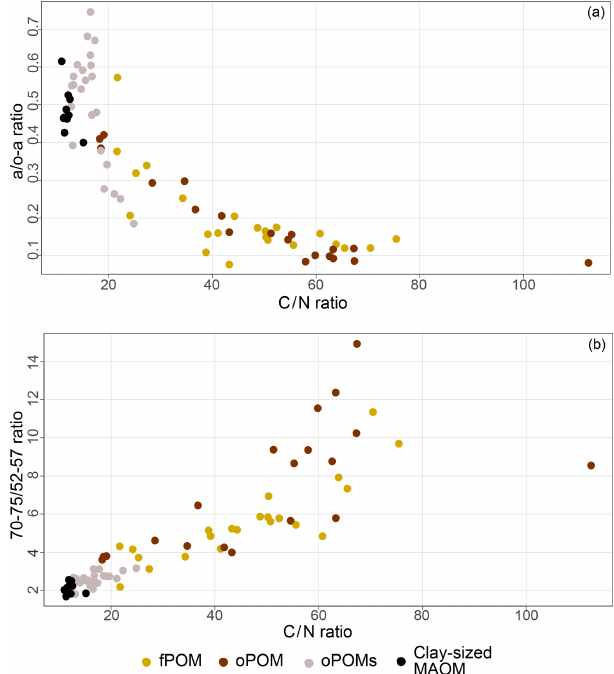
Figure 7. Relation between decomposition proxies and the C / N ra- tio of distinct SOM fractions: 13 C CP-MAS NMR spectroscopy de- rived decomposition proxies for the a / o-a ratio (a) and 70–75 / 52– 57 ratio (b) vs. the C / N ratio for free particulate OM (fPOM), occluded particulate OM (oPOM), small occluded particulate OM (oPOMs) and clay-sized mineral-associated OM